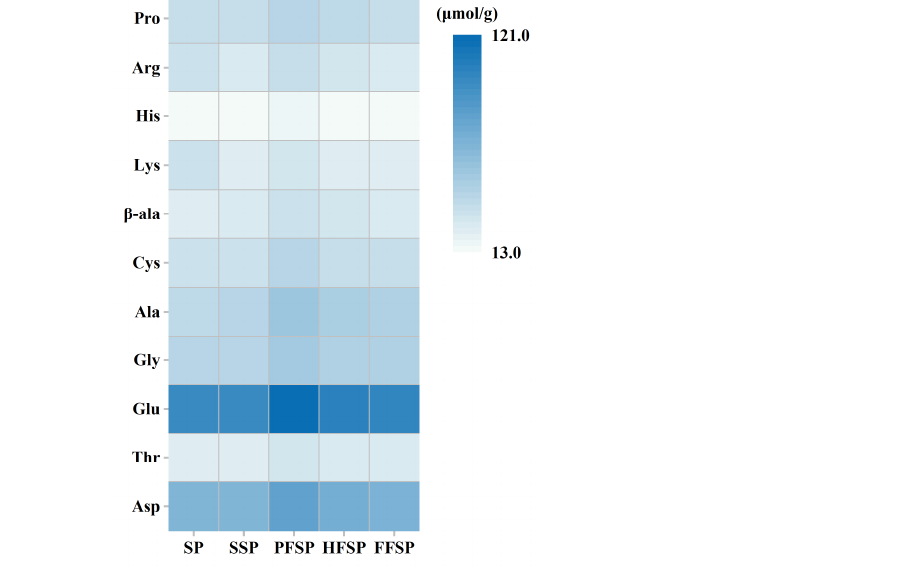
Figure 1. Heat map of amino acid composition in different soybean meal powders. SP: soybean meal powder; SSP: sterilized soybean meal powder; PFSP: Pleurotus ostreatus fermented soybean meal powder; HFSP: Hericium erinaceus fermented soybean meal powder; FFSP: Flammulina velutipes fermented soybean meal powder.